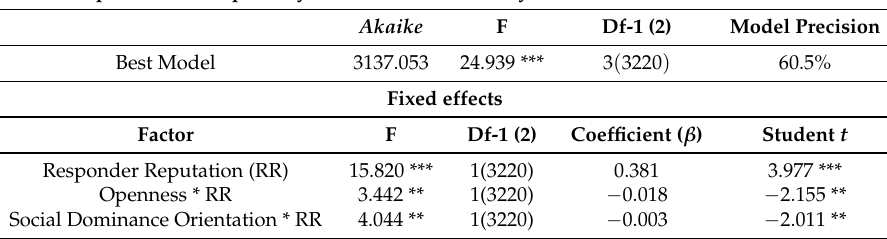
Table 4. Generalised Linear Mixed Models 1. Effects of Reputation and “Reputation Susceptibility” on the Donation Phase.